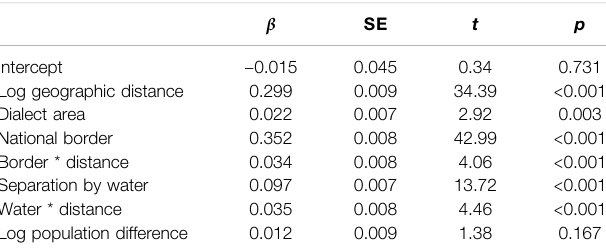
TABLE 11 | Linear mixed-effect modelling results for the Church and religion domain, showing beta coef fi cients, standard errors, t-values and signi fi cance levels.